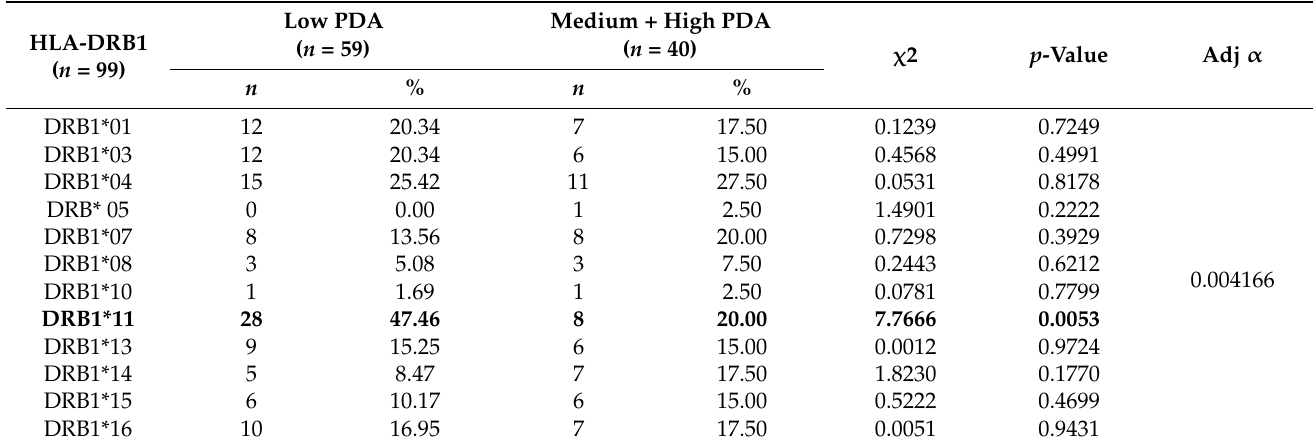
Bold text indicates a statistically significant difference between the two groups. Table 4. Correlation between PDA and HLA-DRB1.